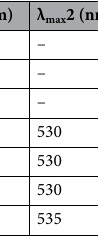
Table 6. Influence of pH on the UV–Vis absorption of the dye 4a